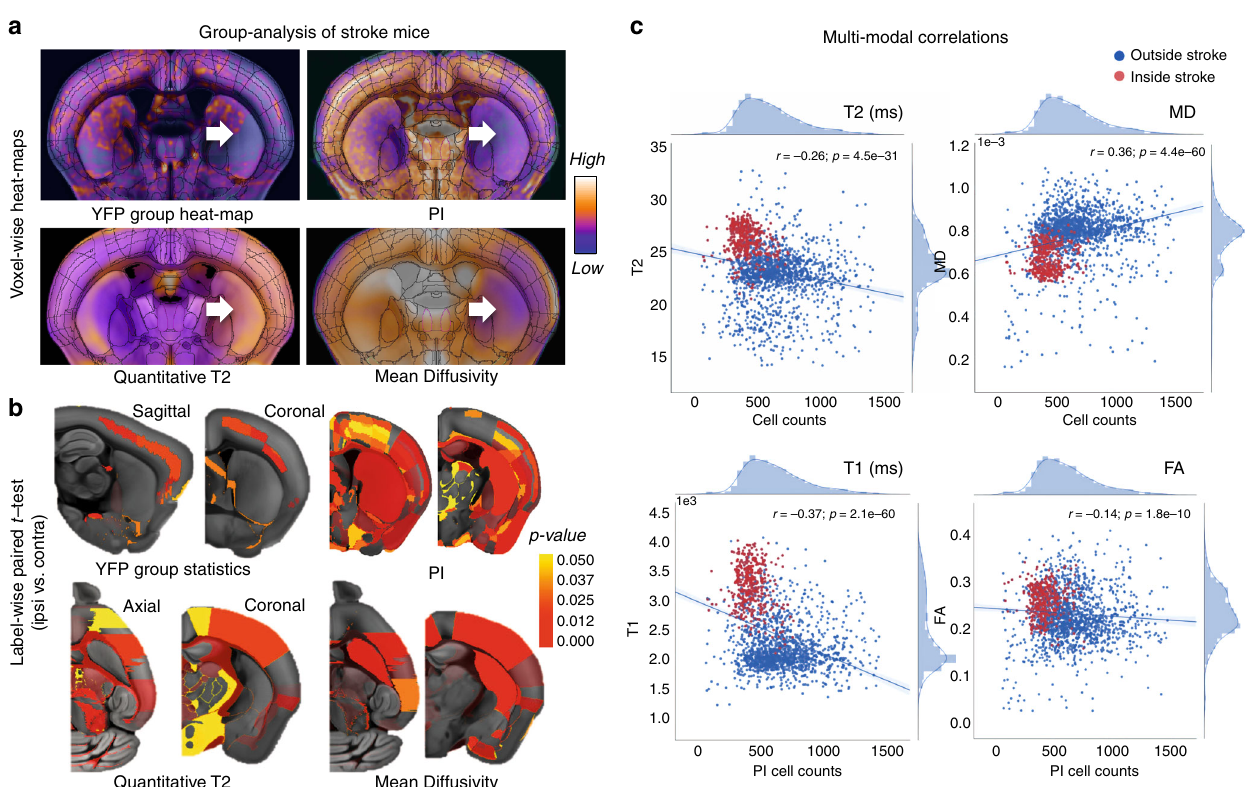
Fig. 3 MRI measures correlate with CLARITY features in acute stroke. a Voxel-wise heat-maps (averaged across mice) depict the relative levels of yellow fl uorescent protein (YFP), propidium iodide (PI), transverse relaxation time (T2), and mean diffusivity (MD) averaged over all 10 stroke mice, demonstrating acute changes in right-hemisphere stroke discerned by both CLARITY and MRI (white arrows). b Group-level statistical maps showing differences between ipsilateral and contralateral regions for Thy1-YFP, PI, T2, and MD. Color bar represents signi fi cance levels (label-wise p values) thresholded at alpha 0.05. c CLARITY – MRI correlations demonstrating a positive correlation of MD and a negative correlation of T1 with neuronal counts. Voxel-wise heat-map correlations of PI cell counts with quantitative MRI parameters (relaxometry: T2/T1, diffusion: MD, fractional anisotropy (FA)). Spearman ’ s rank correlations between PI cell counts and MRI parameters show a substantial decrease in MD values as well as an increase in quantitative T2 and T1 values in the stroke region (red) as compared to the unaffected brain regions